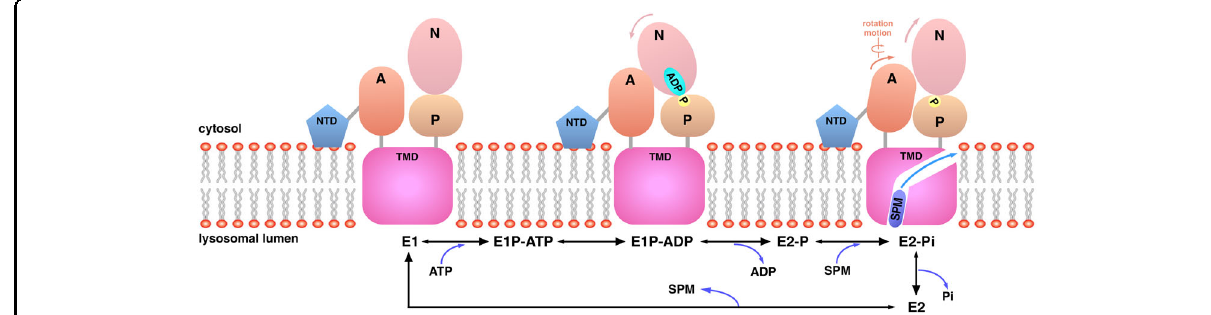
Fig. 5 Proposed mechanism of SPM transport by ATP13A2. Schematic model of the SPM transport cycle by ATP13A2, according to the Post- Albers mechanism. The model is depicted with the same colors as in Fig. 1a and colored arrows indicate the coming movements of the corresponding domain to the following